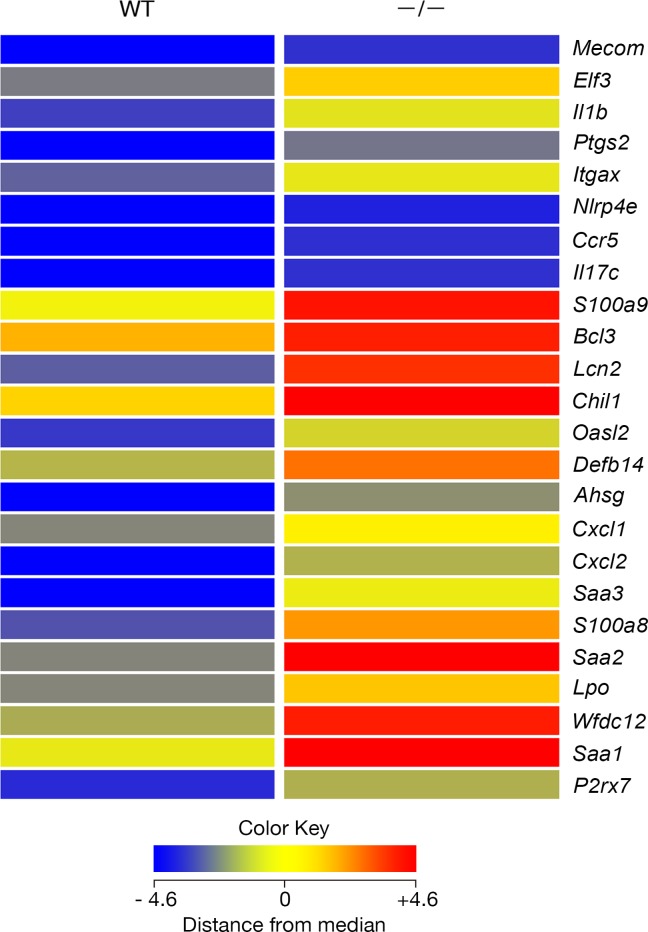
Tiling heat map of the expression of “defense response” genes in wild-type and in Tgm1–/–epidermis.Each color represents the mean expression of duplicate samples from each type of mouse (19.5 dpc pups, n = 2). Those genes were expressed in Tgm1–/–mouse epidermis (–/–) more than 5-fold higher than in wild-type epidermis (WT).